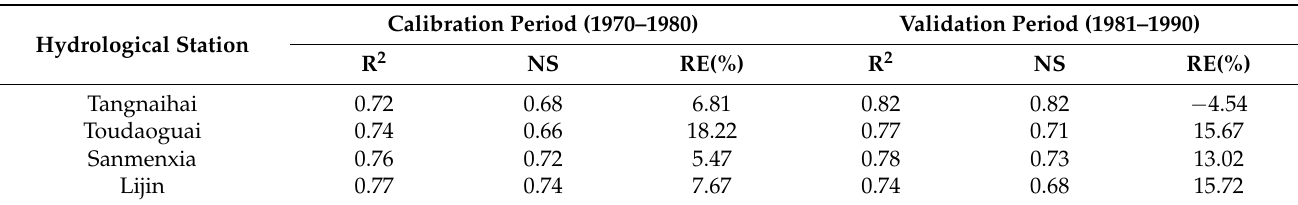
Figure 5. Monthly flow observation and simulation values of Tangnaihai ( a ), Toudaoguai ( b ), Sanmenxia ( c ) and Lijin ( d ) during validation period (1981–1990). Table 4. Determination coefficient ( R 2 ) , Nash–Sutcliffe coefficient ( NS ) , relative error ( RE ) values for calibration and validation period.